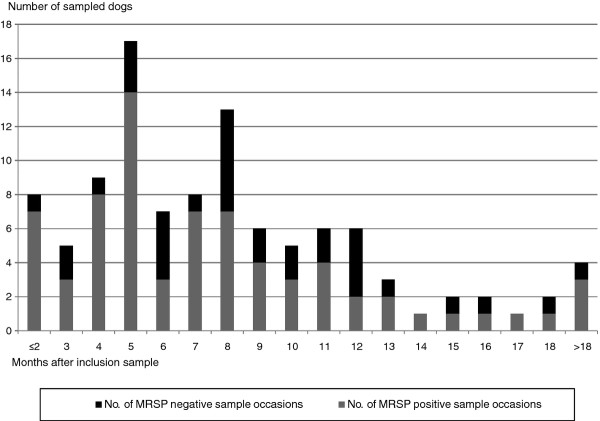
Overview of sampled dogs over months.